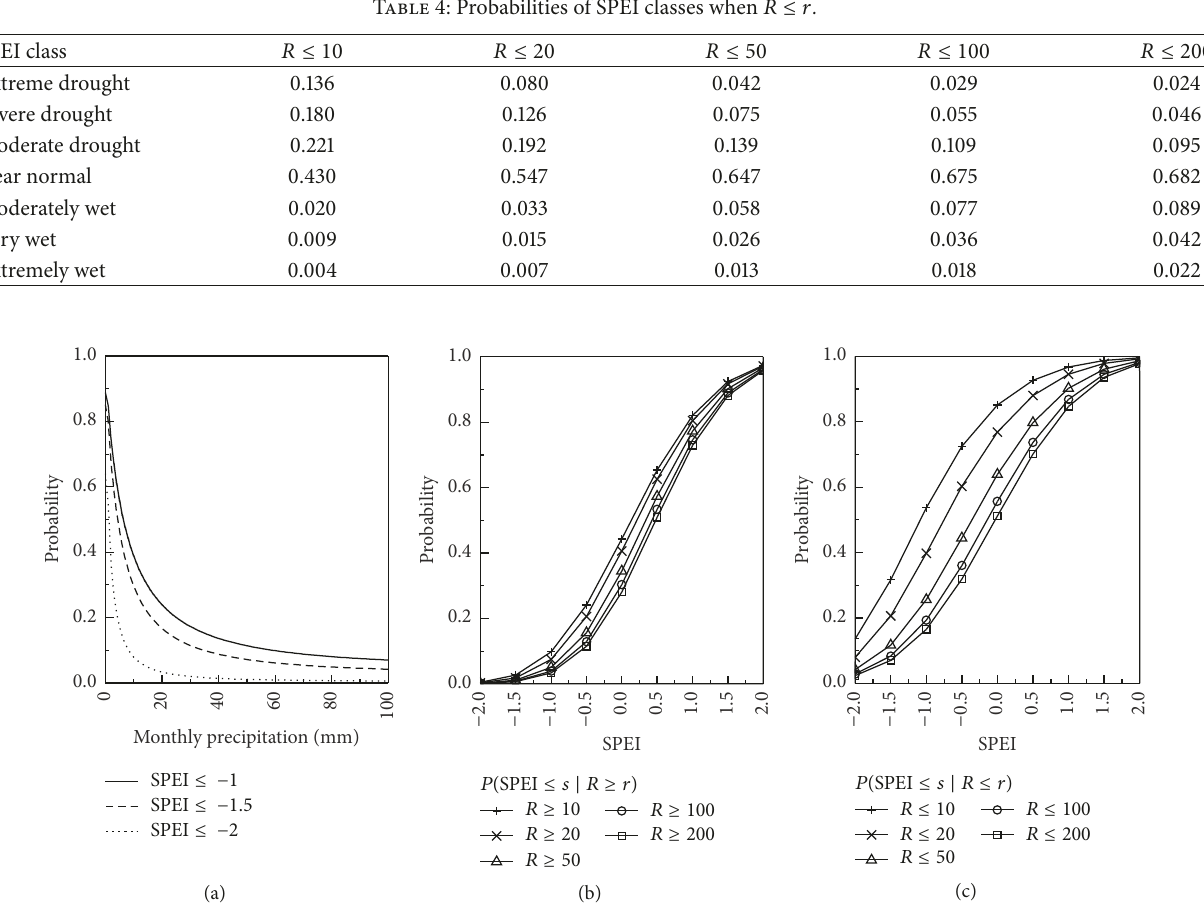
Figure 7: Conditional probability distributions of (a) 𝑅 = 𝑟 , (b) 𝑅 ≥ 𝑟 , and (c) 𝑅 ≤ 𝑟